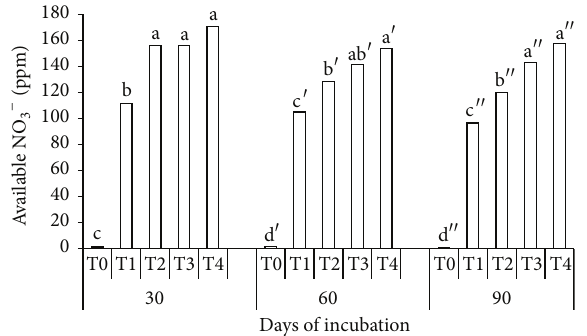
Figure 4: Effects of treatments (T0, T1, T2, T3, and T4) and periods (30, 60, and 90 days) of incubation on soil available nitrate. Note